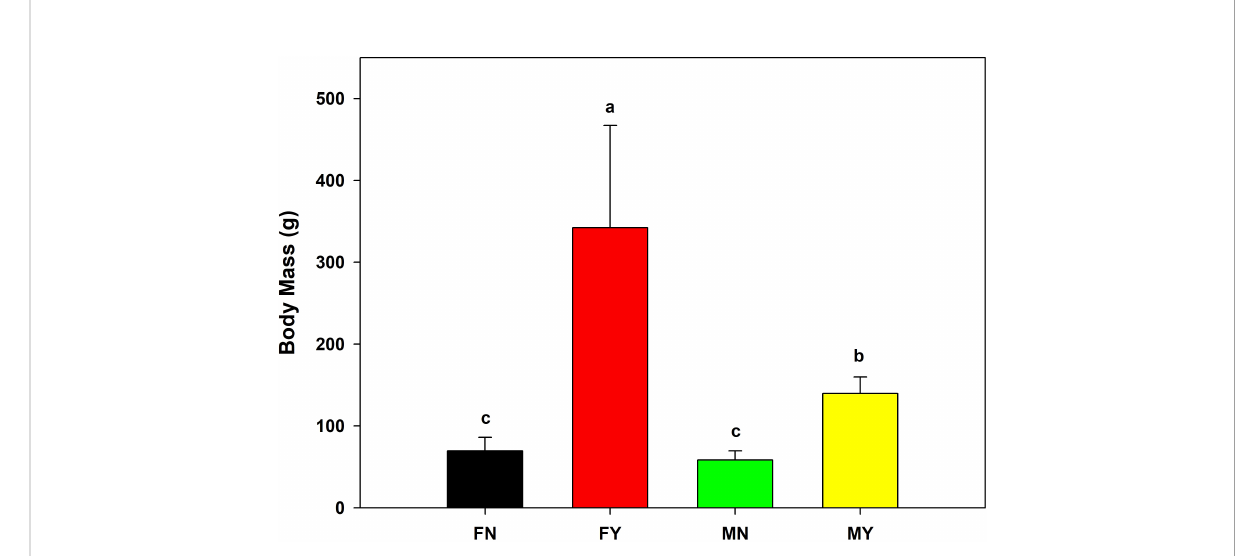
FIGURE 2 Body masses of medium-form populations of Sthenoteuthis oualaniensis . Signi fi cant differences are indicated by different letters (p < 0.05).